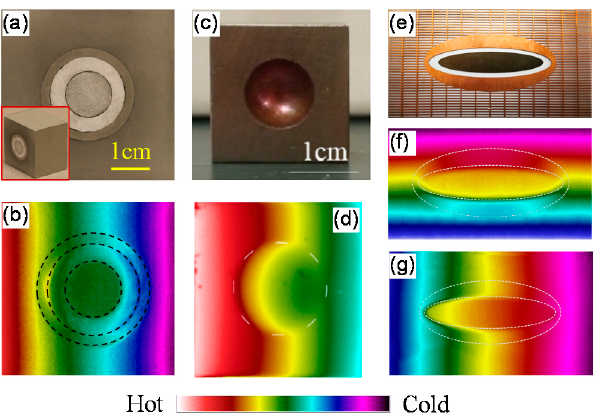
Figure 4. Demonstration of bilayer thermal cloaks. ( a ) Photograph of the 2D cloak [56]; ( b ) measured temperature distribution of ( a ); ( c ) photograph of the 3D cloak [20]; ( d ) measured temperature distribution of ( c ); ( e ) photograph of the elliptical cloak [6]; ( f ) measured thermal profile when heat flows from bottom to top; ( g ) measured thermal profile when heat flows from left to right.